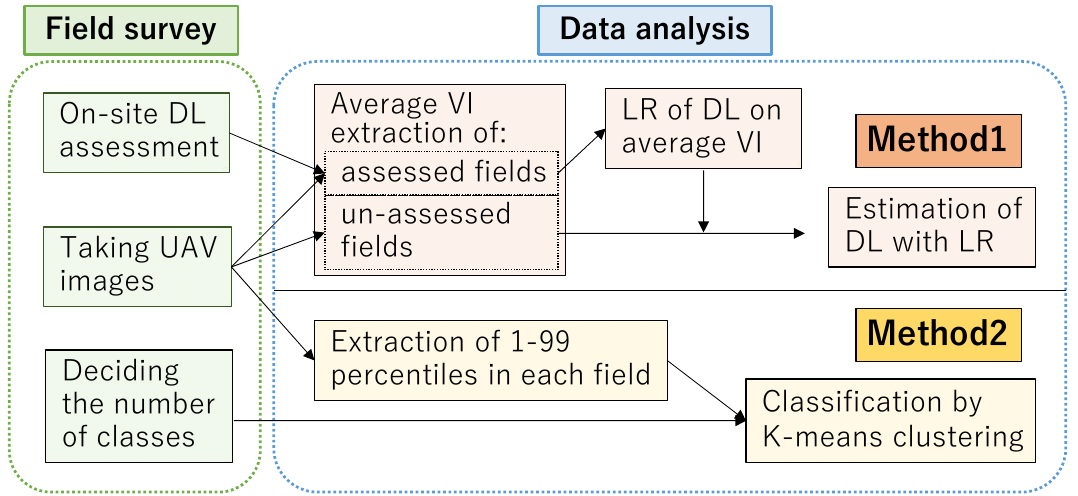
Figure 4. Flow chart of two methods for drought damage assessment.